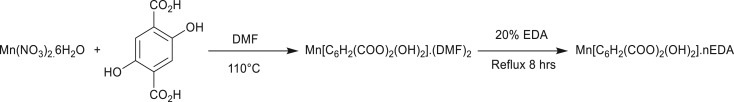
Reaction scheme for EDA-Mn-DOBDC synthesis.